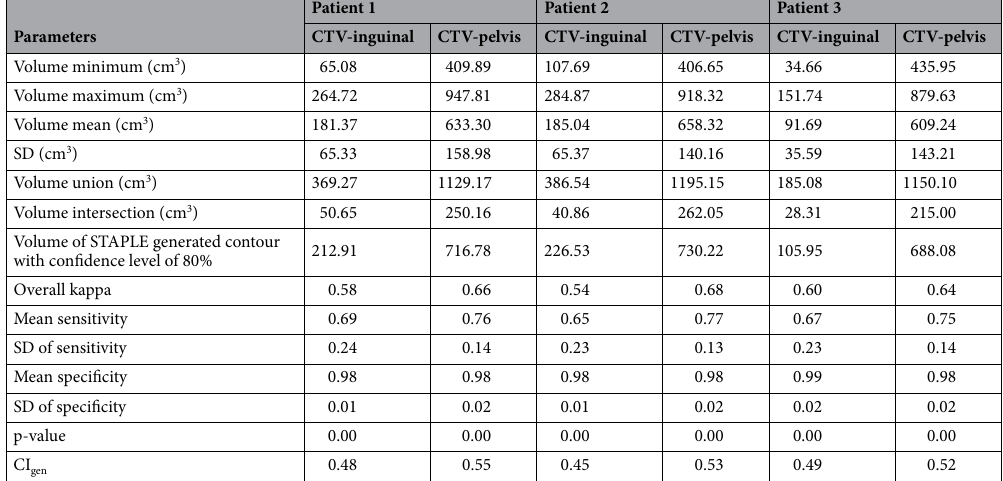
Table 2. Summary of clinical target volume (CTV) statistics. SD standard deviation, CI gen generalized conformity